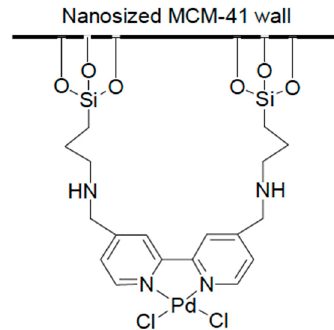
Figure 29. MCM-41 anchored to palladium bipyridyl complex-catalyzed. Reproduced with permission from [41]. Copyright 2009 Elsevier B.V.